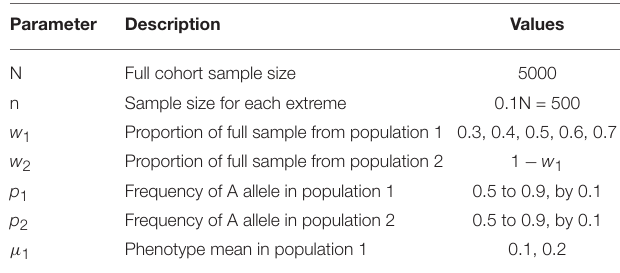
TABLE 1 | Genetic and phenotypic parameter settings for simulations to assess confounding effect of population